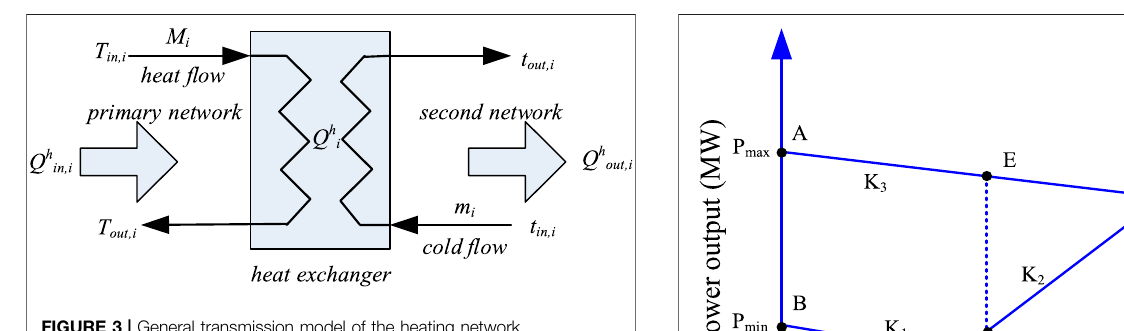
FIGURE 3 | General transmission model of the heating network.